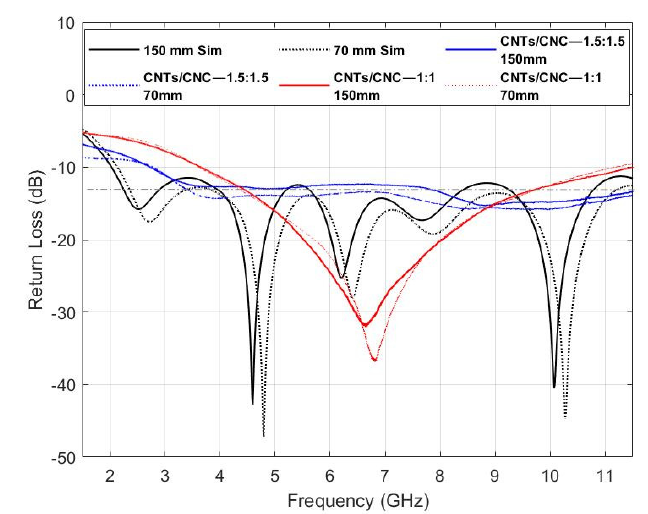
Figure 13. Simulated vs. Measured S 11 of CNTs/CNC PICA antennas under 70 and 150 mm bending scenarios.